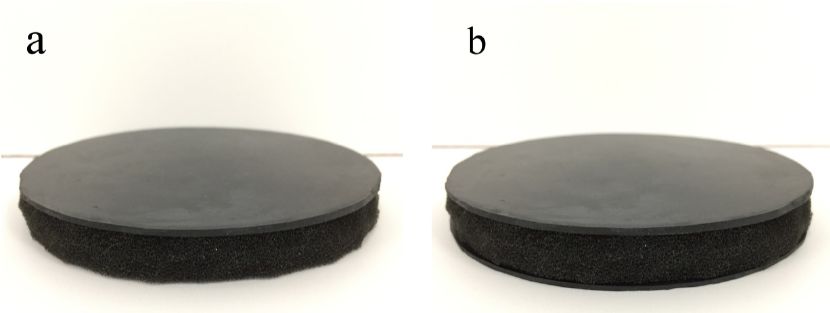
Figure 2. Actual shape of the NBR-PUFM composites: ( a ) double-layer structure; ( b ) sandwich structure.